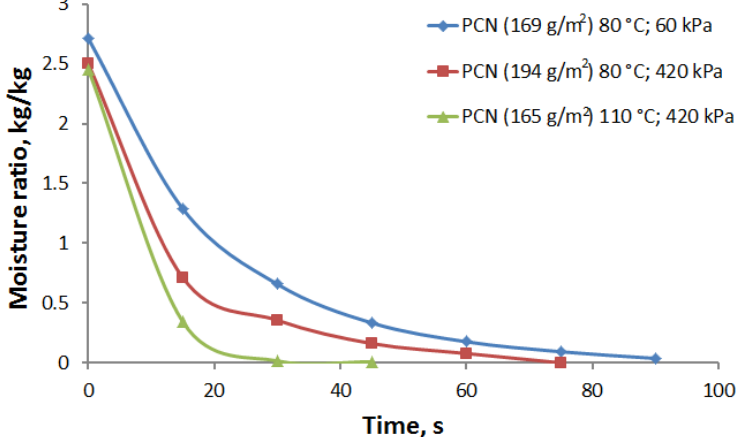
Figure 6. Moisture ratio vs. time for PCN sheets in hot press dewatering for varied pressure and